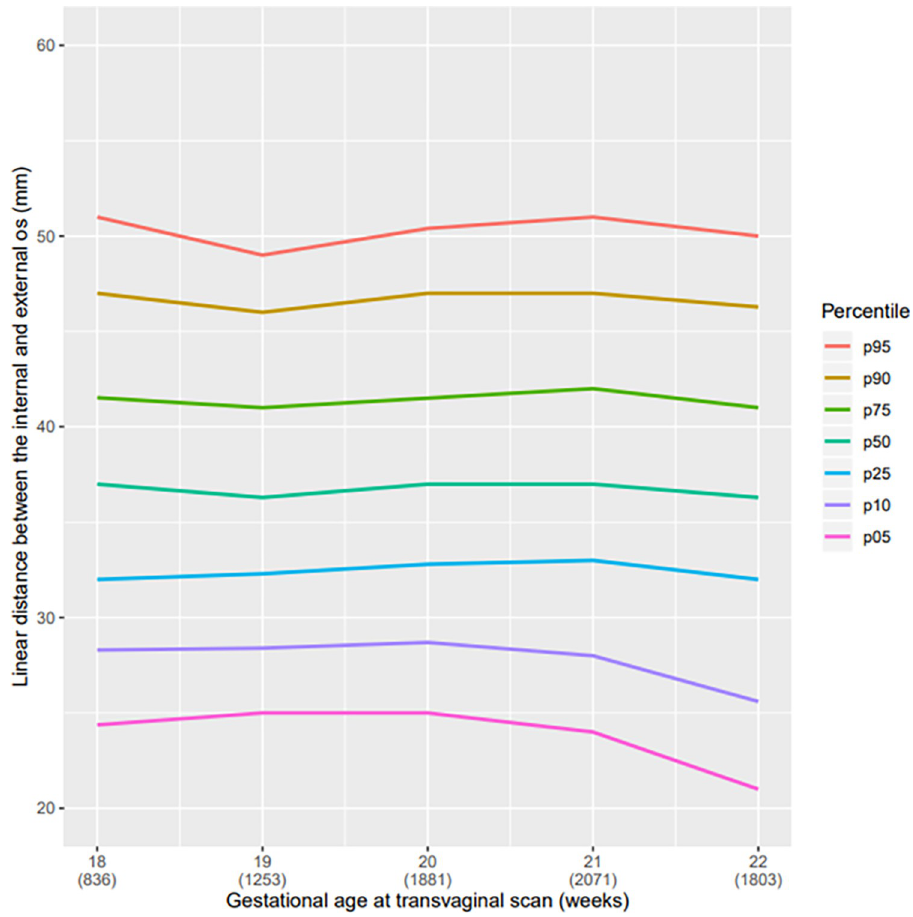
Fig 4. Curve of percentile values for the linear CL measurement. Curve of percentile values for the linear distance between the internal and external os according to gestational age (weeks) at transvaginal scan.